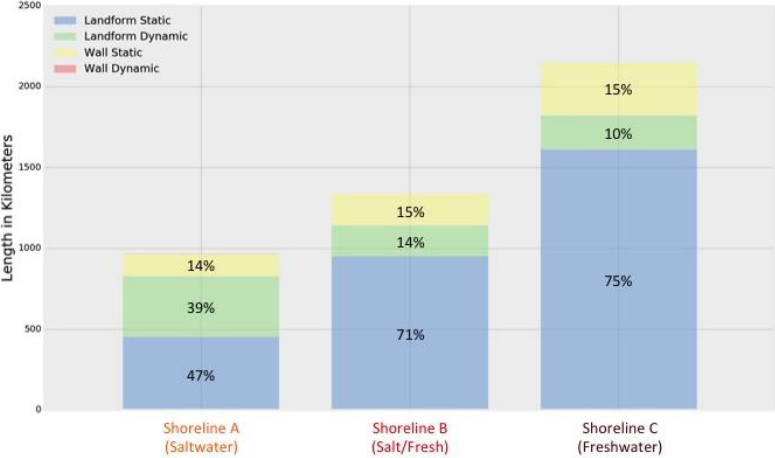
Figure 4. Chart showing each of the three shorelines A, B, and C. For each, the bar chart shows their total length, the length of each of the four coastal infrastructure types, and the percentage of each coastal infrastructure type. Note that dynamic walls are less than 1%, and therefore cannot be seen clearly in this figure.